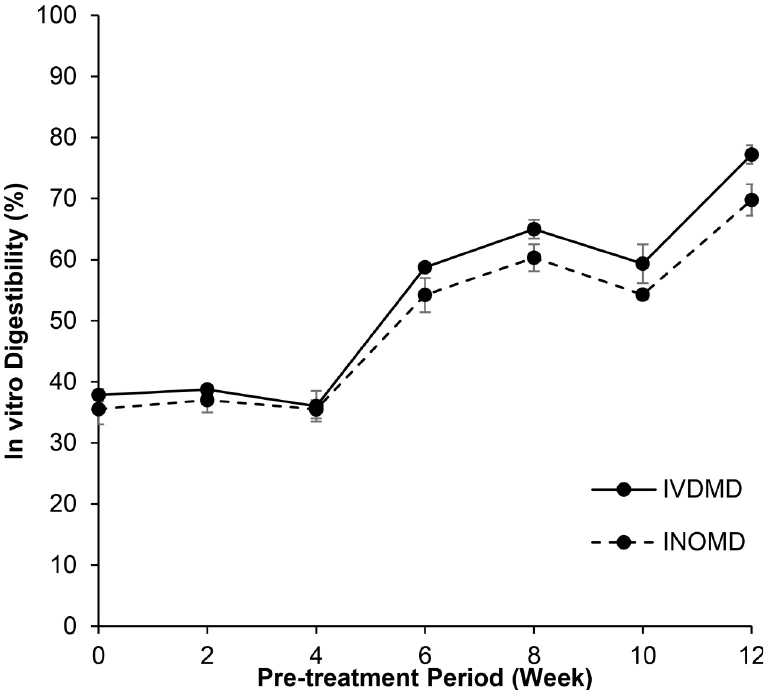
Fig 4. In vitro dry matter digestibility (IVDMD) and organic matter digestibility (IVOMD) of OPEFB pre-treated with G . lucidum at 48 hours of in vitro gas